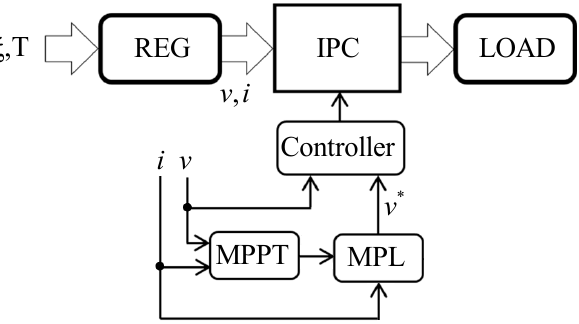
Figure 1. Generalized renewable energy conversion system operating in maximum power point tracking (MPPT) mode. IPC: interfacing power converter; MPL: maximum power line; REG: renewable energy generator.